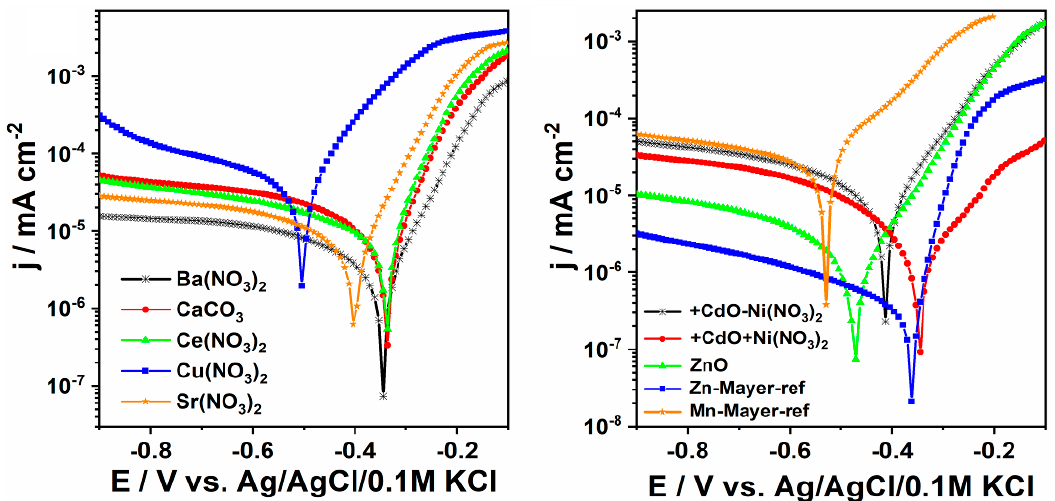
Figure 20. Electrochemical curves for the tested samples.